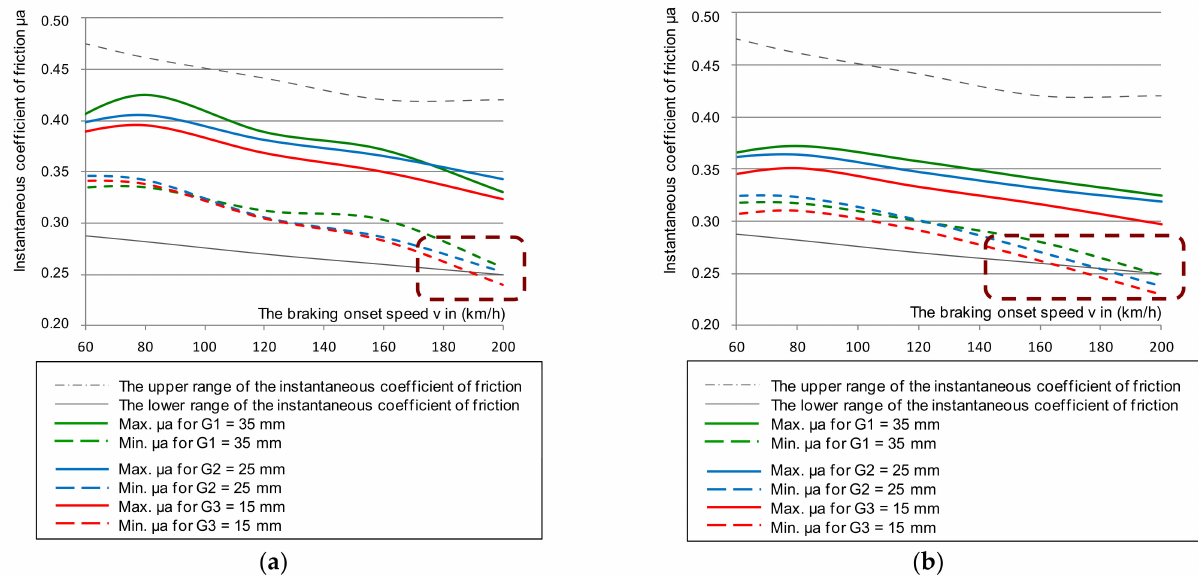
Figure 4. Characteristics of the instantaneous coefficient of friction µ a on the braking initiation speed during braking with a pressure of 44 kN and mass per disc of 7.5 t: ( a ) for a new disc, ( b ) for a worn